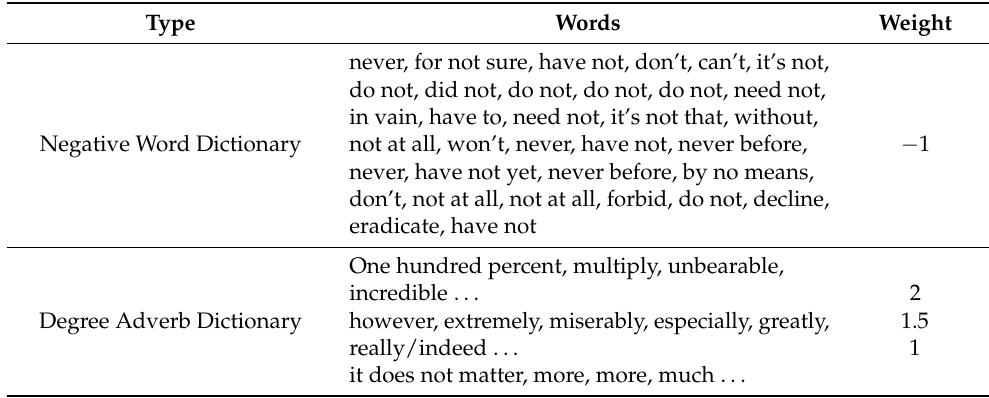
Table A4. Negative word and degree adverb